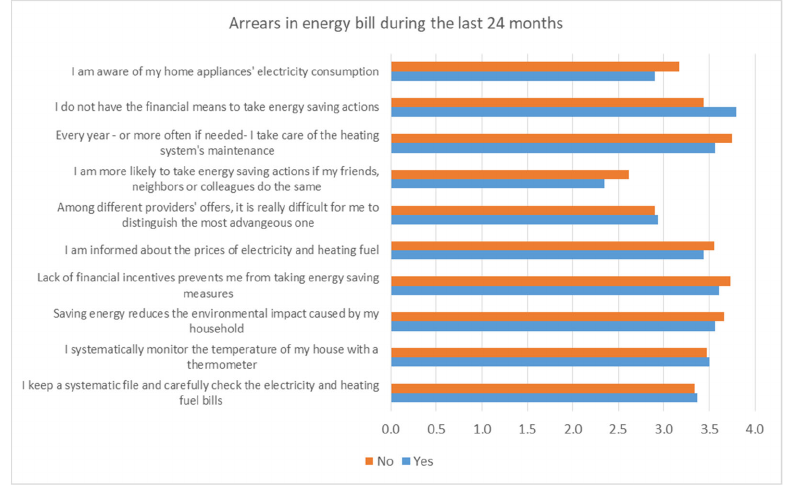
Figure 9. Behavioral statements by energy ‐ vulnerable and non ‐ vulnerable households—“arrears in energy bills” indicator.